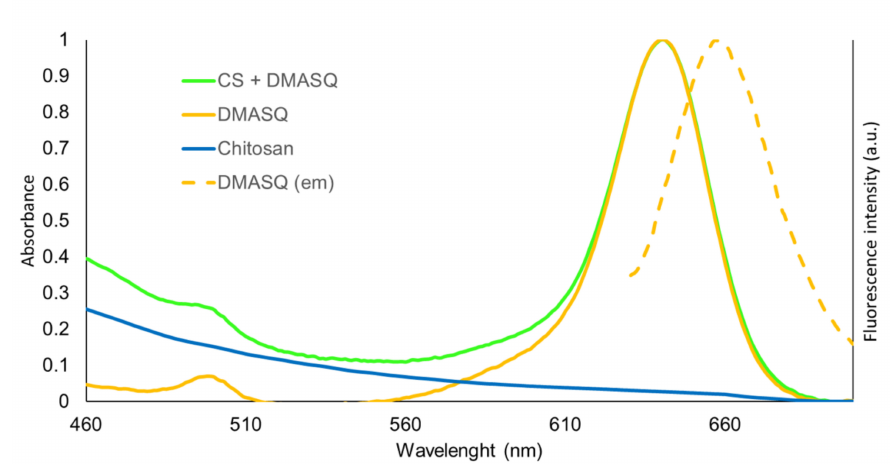
Figure 2. Normalized absorption spectra (solid lines) of DMASQ, chitosan, and chitosan (CS) + DMASQ in the solution of acetic acid + methanol (1:1) and emission spectrum of DMASQ under excitation wavelength 600 nm (dashed line). DMASQ concentration: 6 × 10 − 4 mol/dm 3 , the concentration of acetic acid